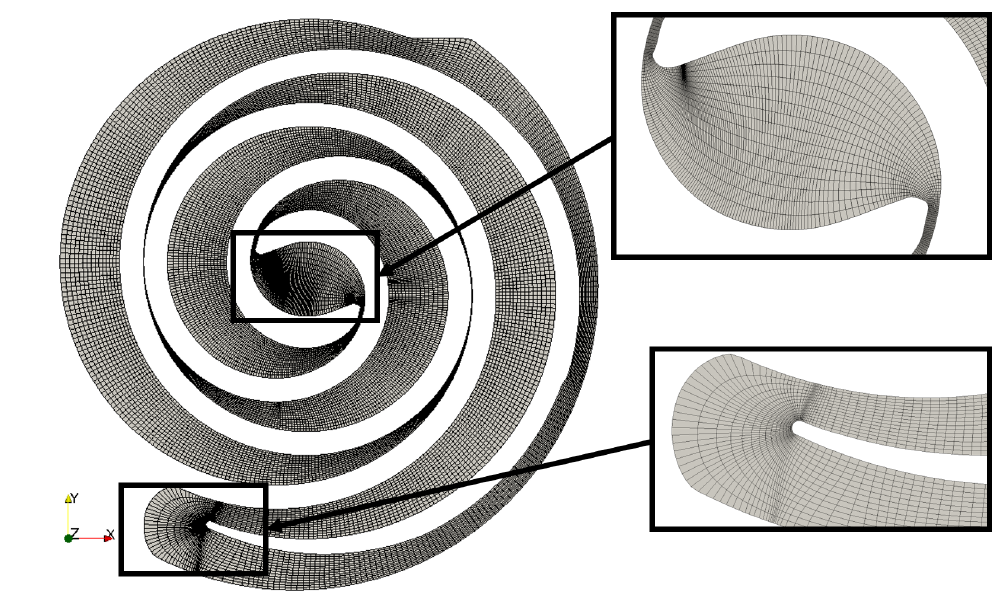
Figure 4. Structured mesh: final result. Table 2. Mesh quality parameters in function of the mobile scroll